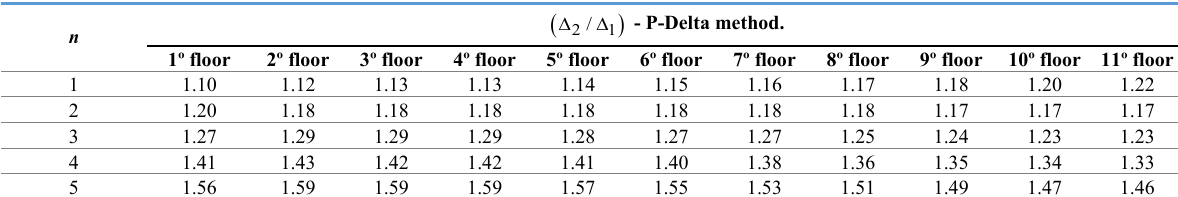
Table 5 – Ratio of initial to final displacements ( ) 2 1 / ∆ ∆ . obtained with the P-Delta method. Source: Authors